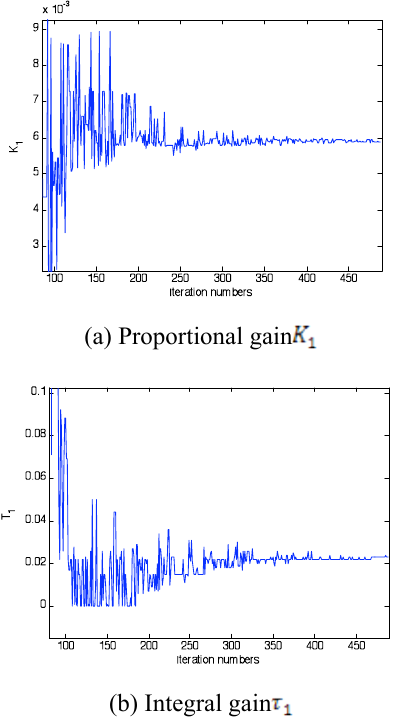
Fig.10. Controller parameters for criterion